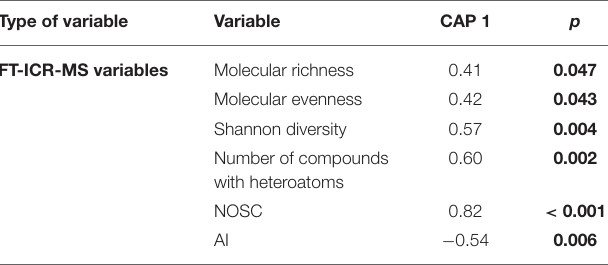
TABLE 3 | Spearman correlation of integrative variables from the FT-ICR-MS dataset with the first axis of the canonical analysis of principal coordinates (CAP) of DOM molecular composition (relative intensities of the 3,900 compounds) using its finally selected key environmental driver, the current riparian forest, as sole explanatory